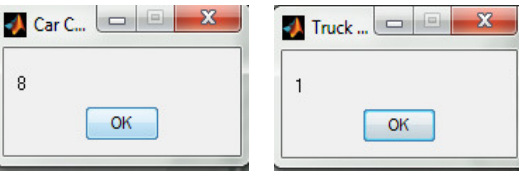
Figure 30: Car & Truck Counts of the ROI